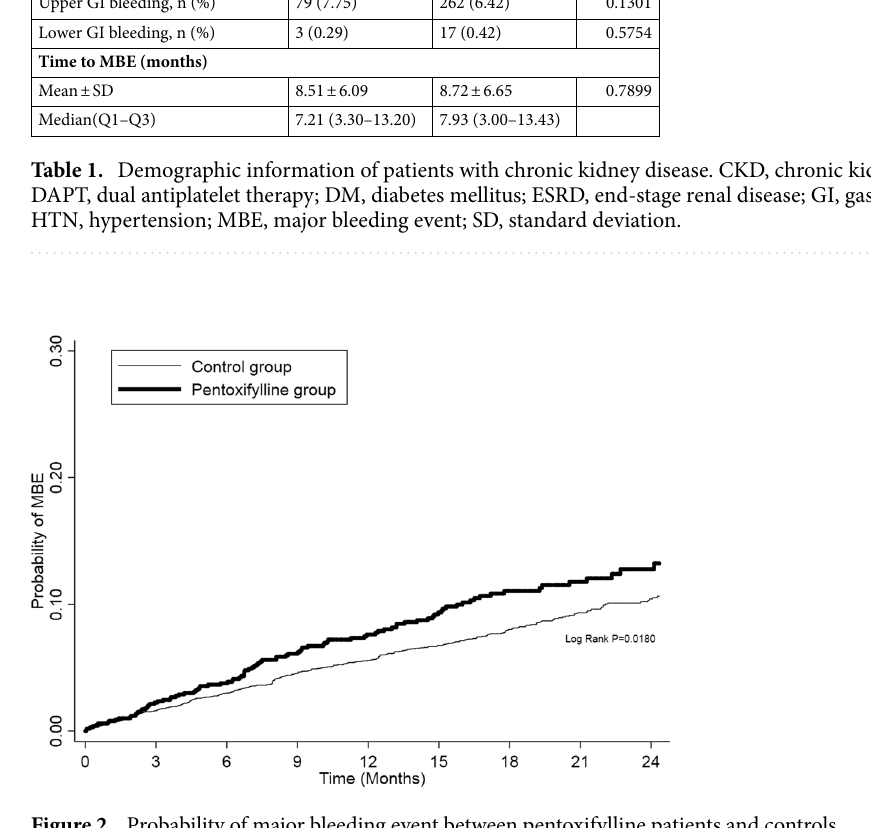
Figure 2. Probability of major bleeding event between pentoxifylline patients and